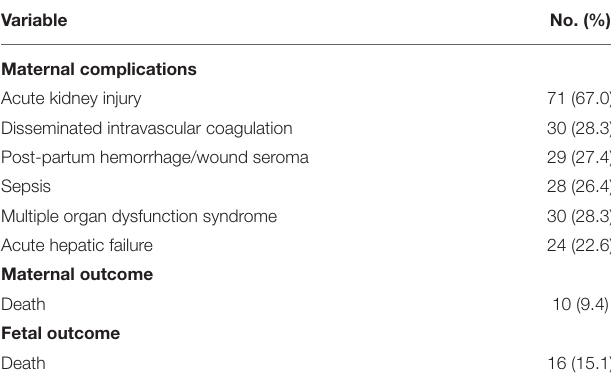
TABLE 4 | Complications and outcomes of patients with AFLP ( n = 106).